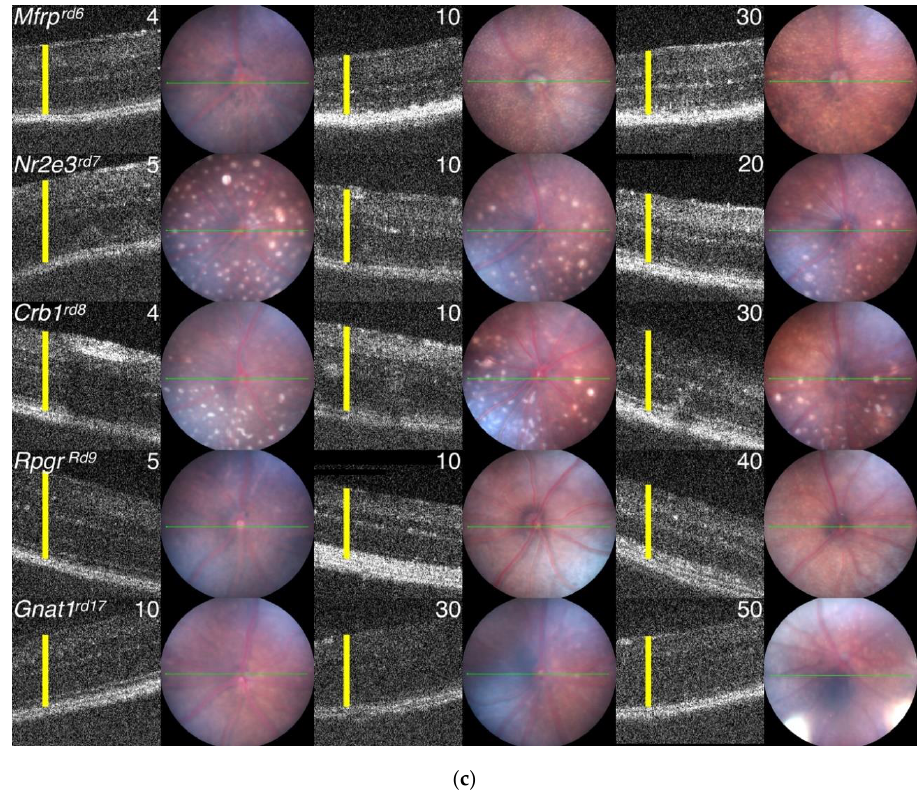
Figure 4. ( a ) Characterization of mouse models from the Eye Mutant Resource (EMR) program at JAX. Example optical coherence tomography (OCT) and fundus images were taken from rapid RD models: